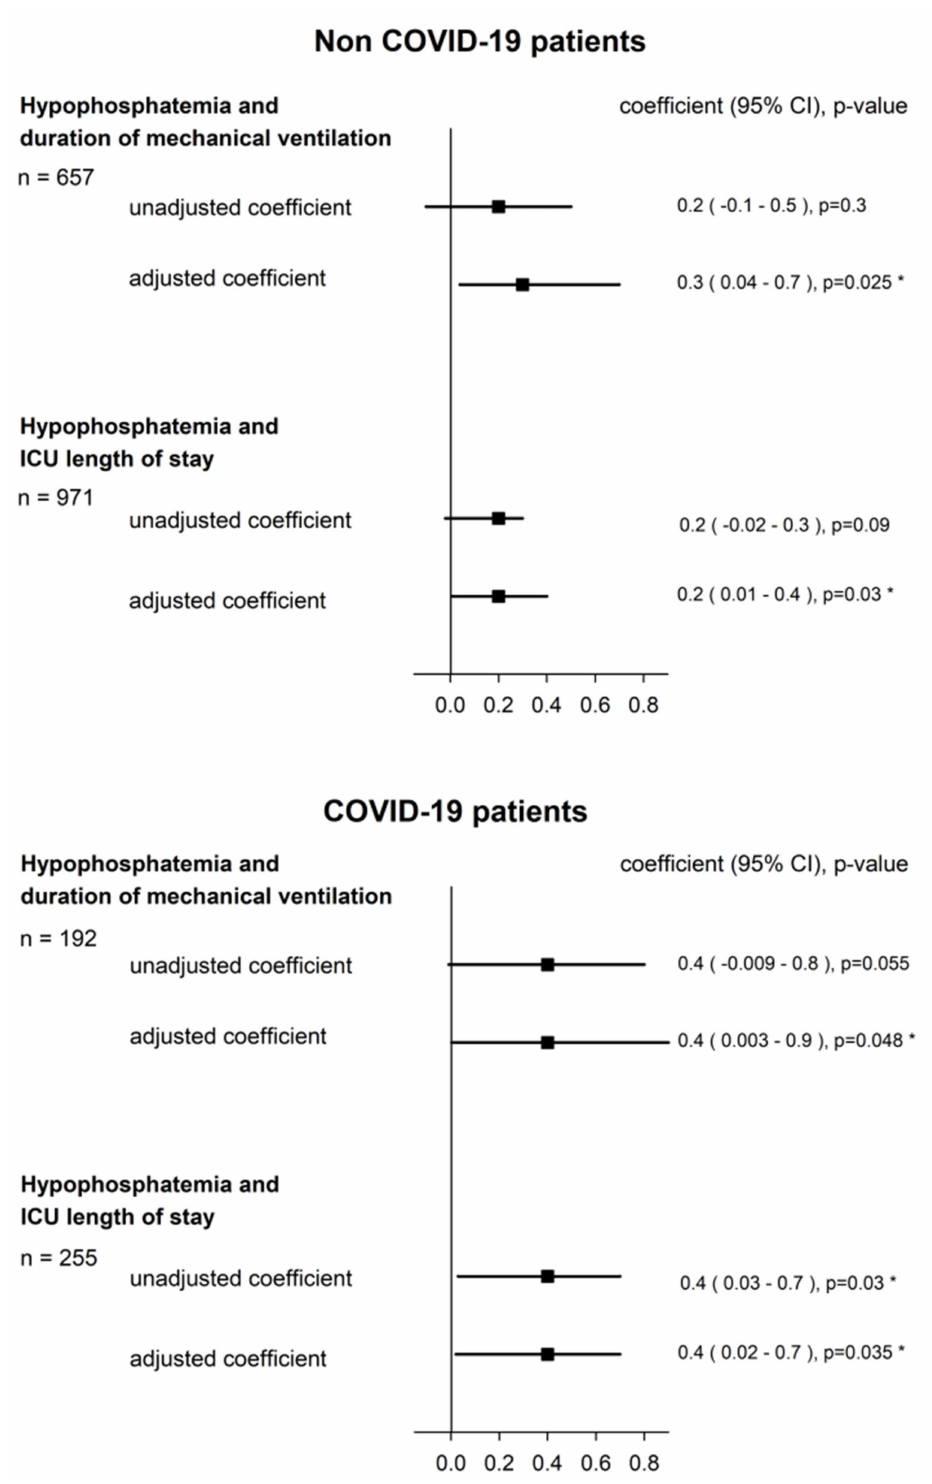
Figure 3. Hypophosphatemia, duration of mechanical ventilation, and ICU LOS in non-COVID-19 patients and COVID-19 patients. Regression coefficient (95% confidence interval) on a logarithmic scale. Adjusted coefficient was adjusted to: gender, SAPSII on ICU admission, infection within the first 48 h, and reason for ICU admission (COVID-19 patients were not further adjusted for reason for ICU admission.). *: p <